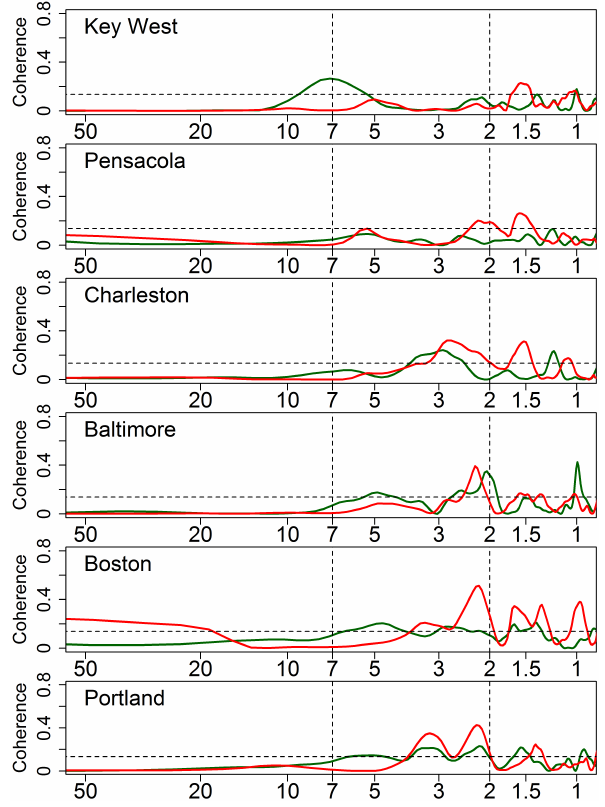
Fig. 9. Coherence between MEI and interannual sea level vari- ations (green), and coherence between the reconstruction from AMOI(ENSO) EOFs and interannual sea level variations (red). The horizontal axis is the spectral period in years. Vertical dashed lines mark ENSO band frequencies, the horizontal dashed line quantifies the threshold to reject the null hypothesis of random coherence at the 95% confidence level (Thompson,